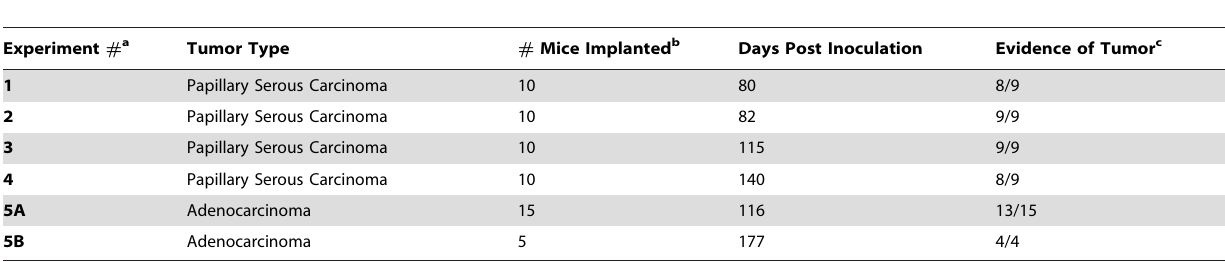
sites within the peritoneal cavity, sections of each organ were taken, fixed and stained. Fig. 3Ac–3Ag reveal the presence of tumor in the ovary, periovarian fat, pancreas, uterus, spleen and liver from a mouse sacrificed 140 days after the injection of tumor- derived cell aggreages (Experiment # 4). Table 1. Frequency of Tumor Development Following i.p. Injection of Tumor Cell Aggregates Derived from Ovarian Cancer Patient Solid